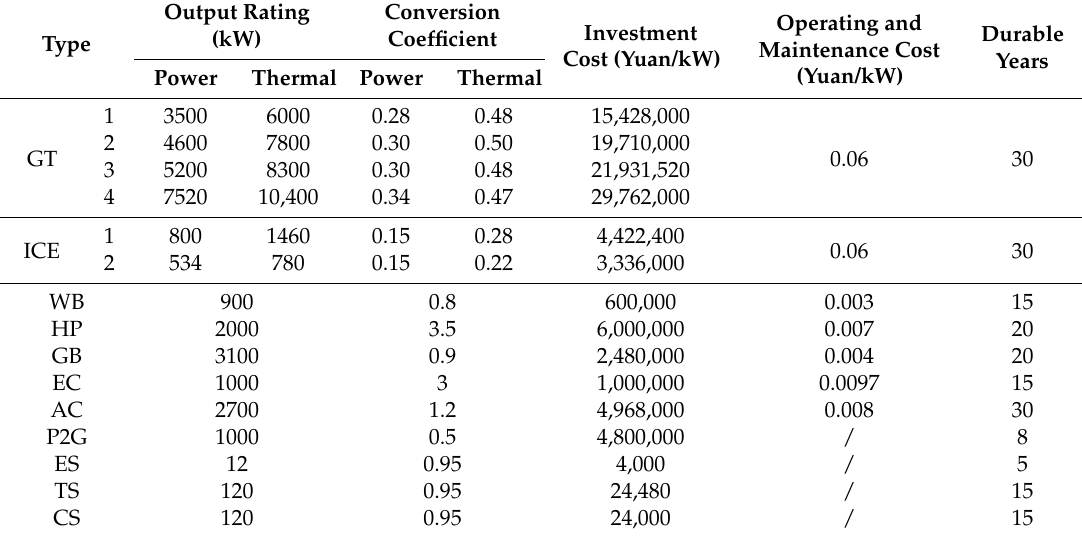
Table A1. Device Table B1. Device parameters.